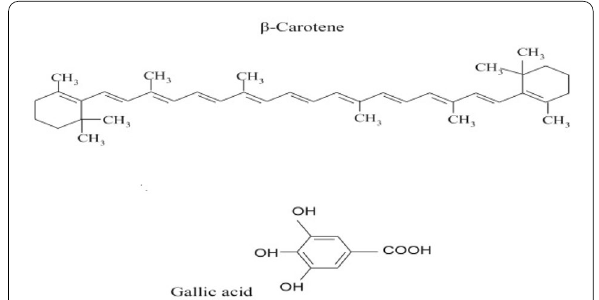
Fig. 1 Chemical structures of β‑carotene and gallic